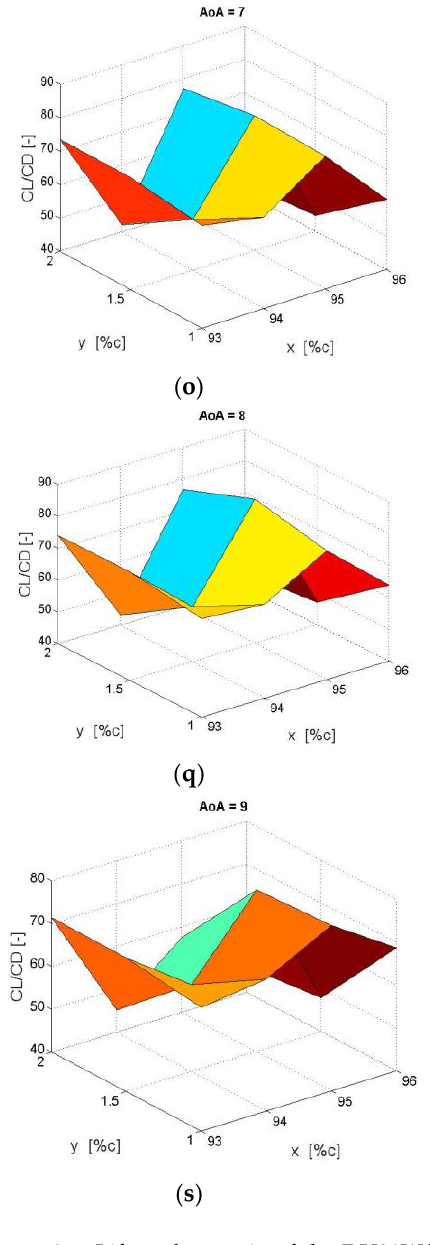
Figure B1. Lift-to-drag ratio of the DU91W(2)250 airfoil with MTs for each AoA. CFD results are represented in the left column and the POD approximation in the right one. Each sub-plot corresponds to an angle of attack AoA of the airfoil.